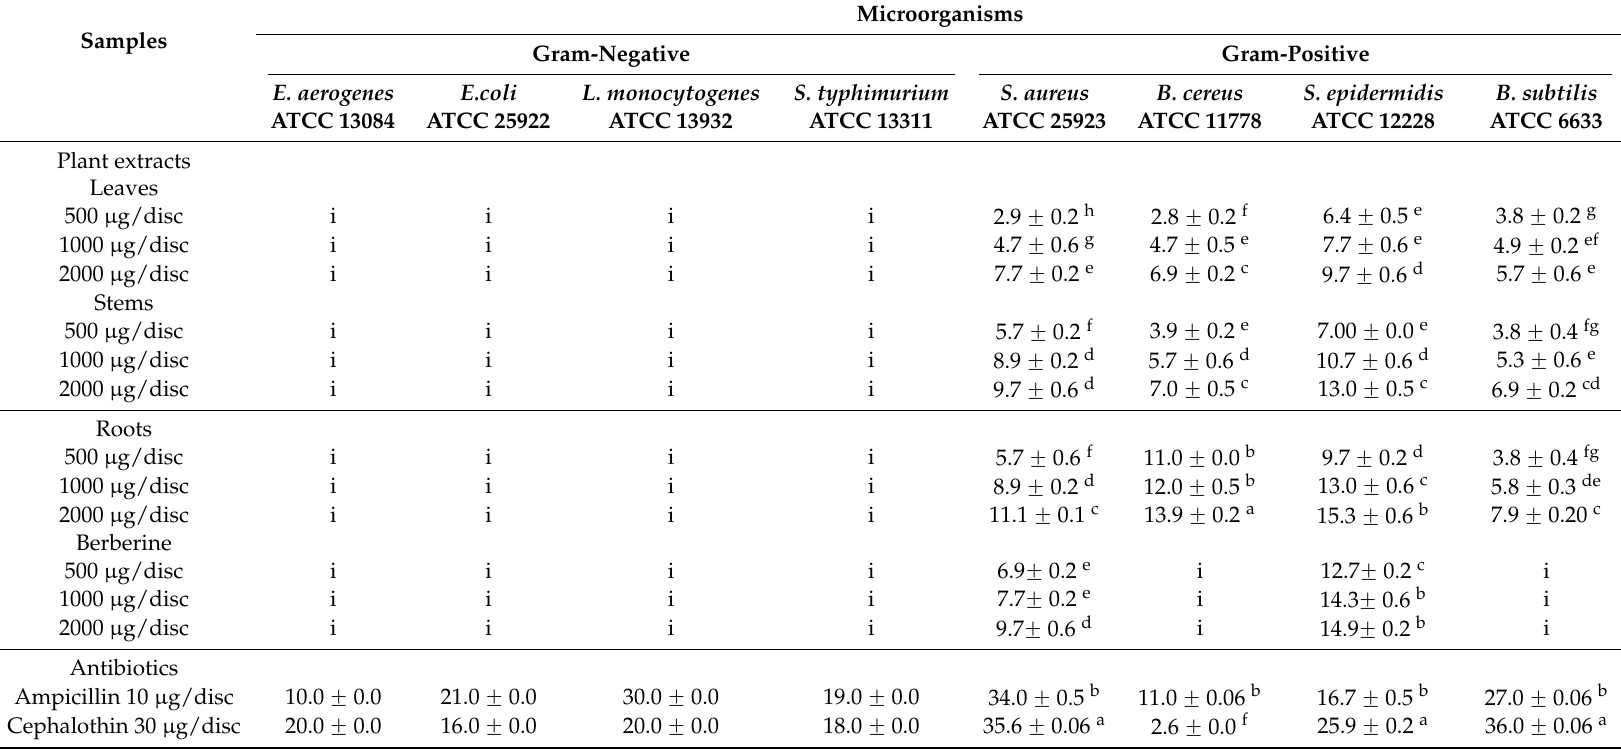
Table 1. Inhibition zone diameters (mm) of alkaloid extracts of Berberis microphylla against pathogenic bacteria a